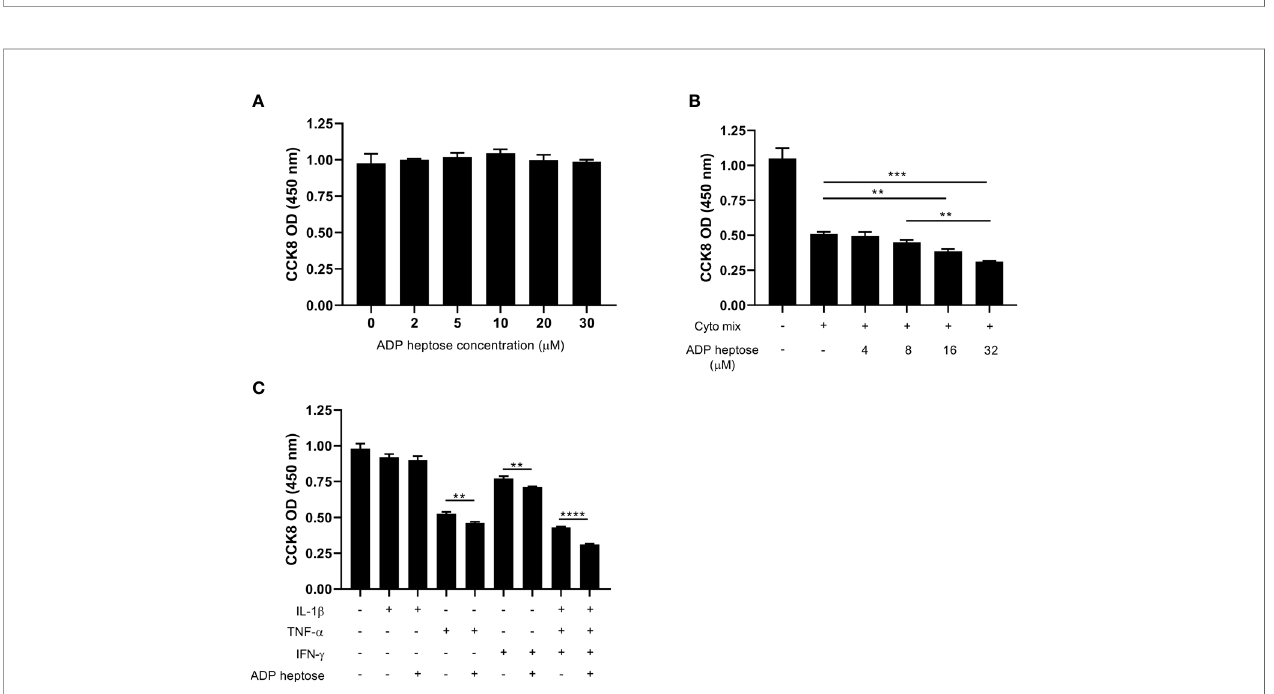
FIGURE 2 | Alpk1 activation synergized with cyto mix to reduce cell viability. The number of viable cells were assayed by CCK-8 solution. (A) 1x10 5 MIN6 cells were treated with vehicle (sterile distilled water), or a series concentration of ADP heptose for 24 hours. (B) MIN6 cells were treated with vehicle (sterile distilled water), or cyto mix, or cyto mix together with elevated concentrations of ADP heptose for 24 hours. (C) MIN6 cells were treated with the indicated cytokine with or without ADP heptose (32 µM) for 24 hours. Data show mean ± SD and are representative of 3 independent experiments. The data shown in (A, B) are were analyzed with ANOVA followed by Tukey ’ s post hoc test, and data in (C) were analyzed with unpaired Student ’ s t-test. **P < 0.01; ***P < 0.001; ****P <